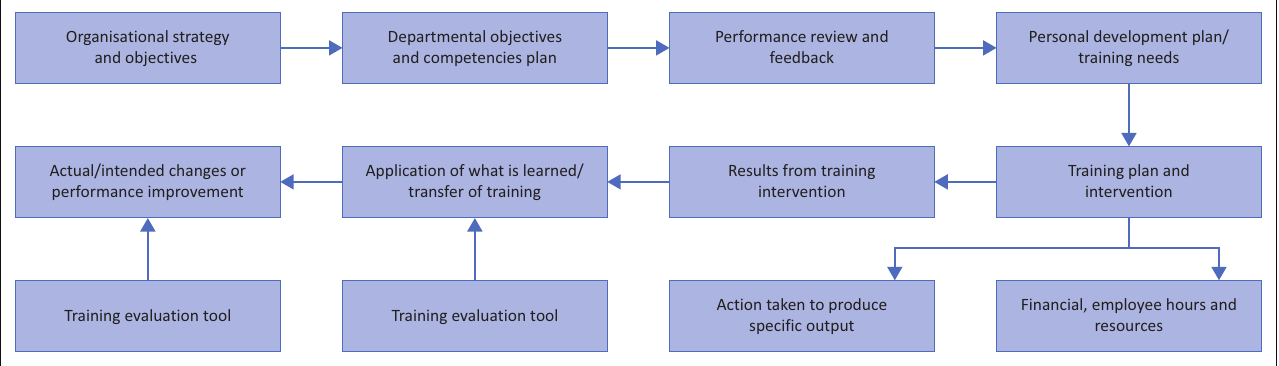
FIGURE 1: Proposed training evaluation framework for performance